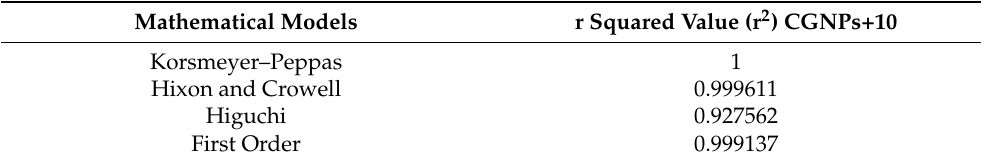
Table 3. Coefficient of in vitro release of different mathematical models for α -tocopherol and the cashew gum particle with 10% of α -tocopherol